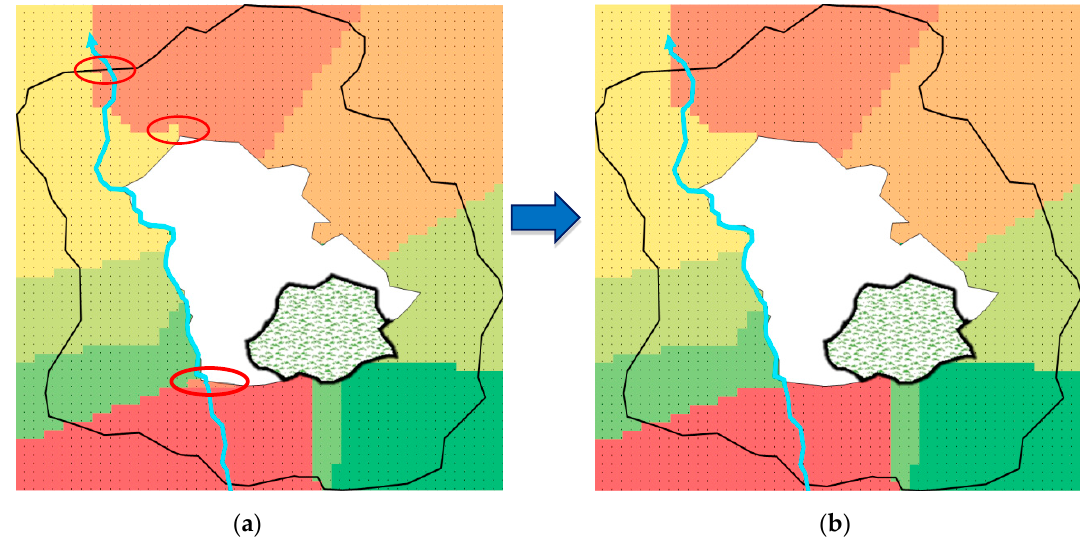
Figure 10. Maps showing ( a ) initial K-means clusters and ( b ) and clusters after merging isolated parcels.